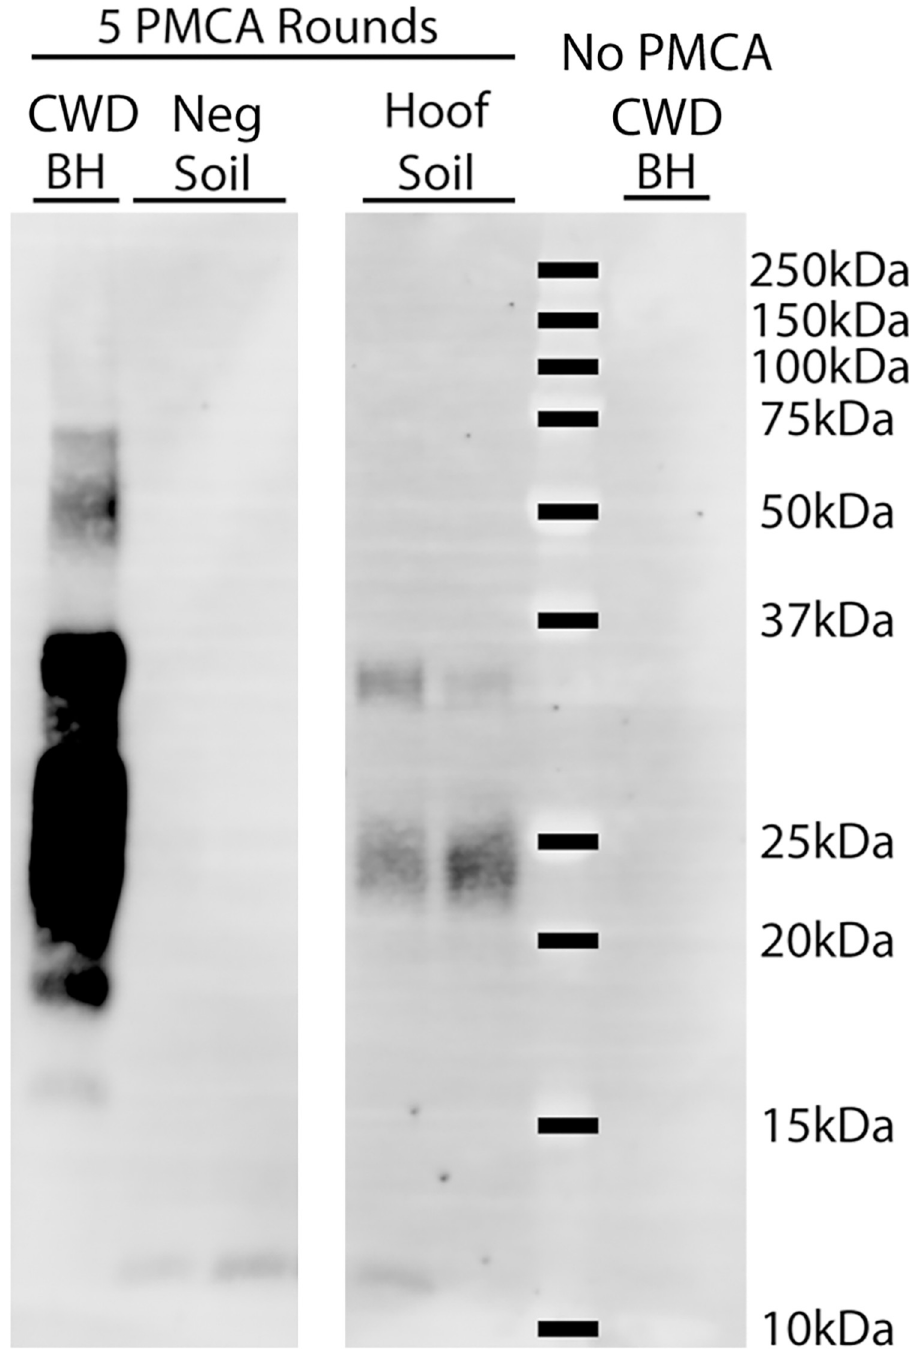
Fig 7. Detection of PrP CWD from soil found between the hoof digits of a CWD-infected mule deer. Soil was assayed for the presence of PrP CWD seeding ability by sPMCA. Samples assayed included soil obtained from between the hoof digits of CWD clinically-positive female mule deer 139177 and soil from a CWD-free region (Neg soil). Following a PrP CWD -extraction procedure, samples were subjected to 5 rounds of PMCA in duplicate. Samples were compared to 0.1% CWD-infected brain homogenate (BH) controls with and without PMCA.